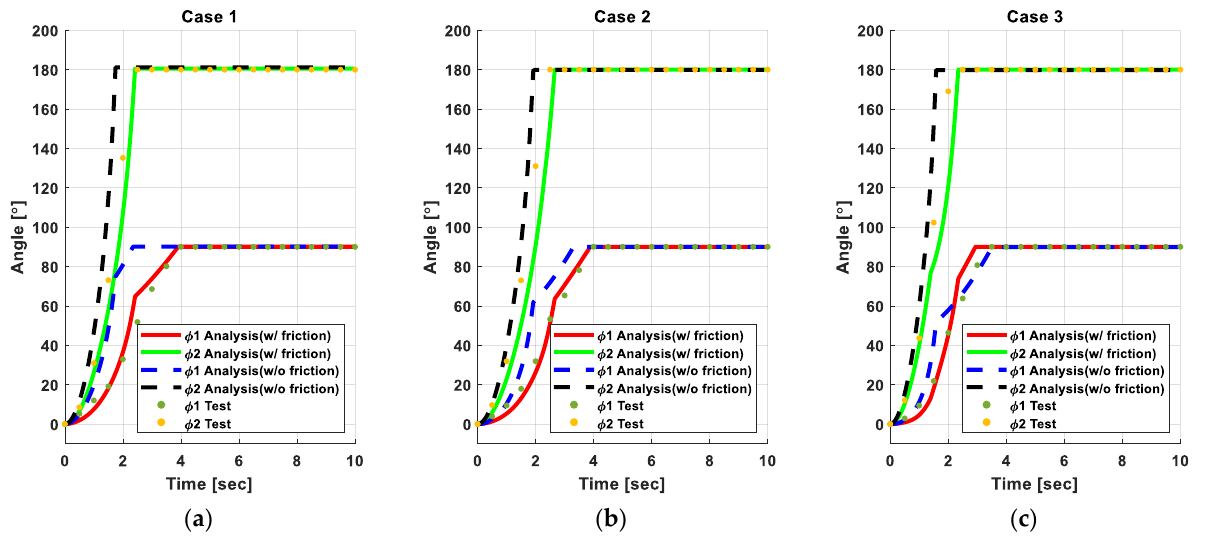
Figure 11. Comparison of the rotation angle history between test and analysis before/after friction compensation: ( a ) case 1, ( b ) case 2, ( c ) case 3. Table 9. Design cases of central composite